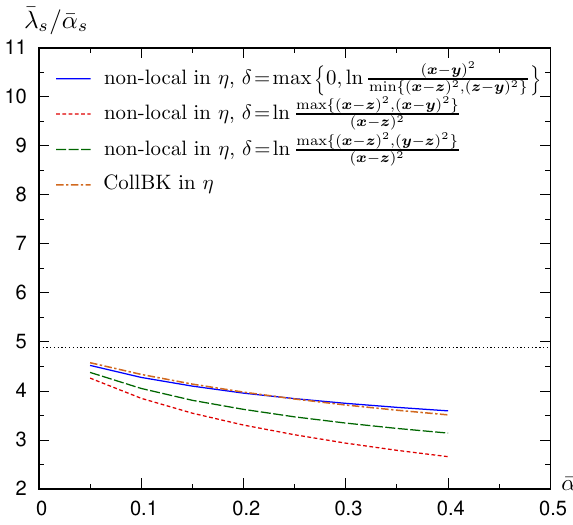
Figure 6 . The asymptotic speed of the front (divided by (cid:22) (cid:11) s ) in the (cid:17) -representation as a function of (cid:22) (cid:11) s and for di(cid:11)erent evolution schemes: cf. eqs. (5.4){(5.5) (blue solid curve), eqs. (5.6){(5.7) (red short-dashed curve), eq. (5.8) (green long-dashed curve) and eq. (7.21) (brown dotted-dashed curve denoted \CollBK in (cid:17) "). All lines are physically acceptable in that they di(cid:11)er from each other and also from the respective result at LO by a correction of relative order (cid:22) (cid:11) s . The (cid:12)nal prescription for the rapidity shift in (cid:17) that we shall explicitly consider